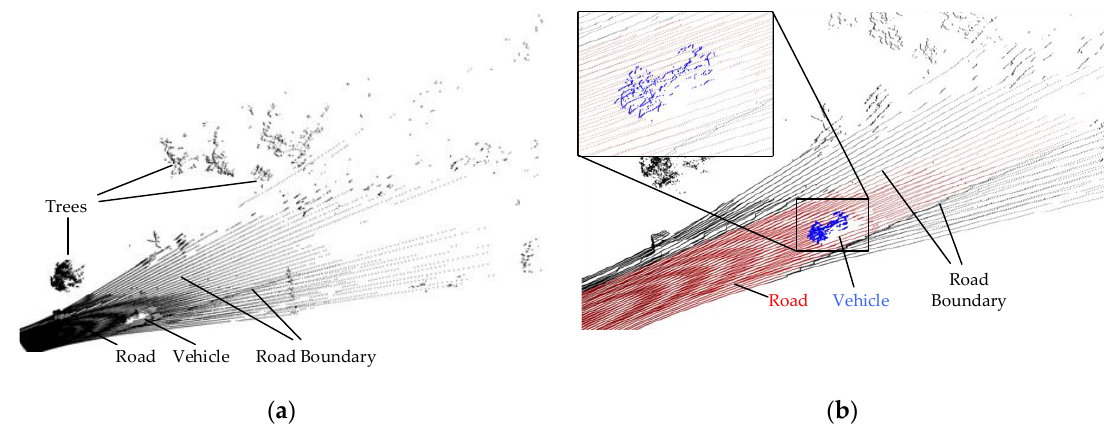
Figure 3. The typical result of the proposed preprocess and segmentation procedure. ( a ) The input point cloud obtained by the roadside Lidar; ( b ) The point cloud result after preprocessing and segmentation procedure, where the red points represent the ground points extracted by RANSAC, and the blue points are the vehicle points clustered by the Euclidean cluster, and the black points are the filtered background points.